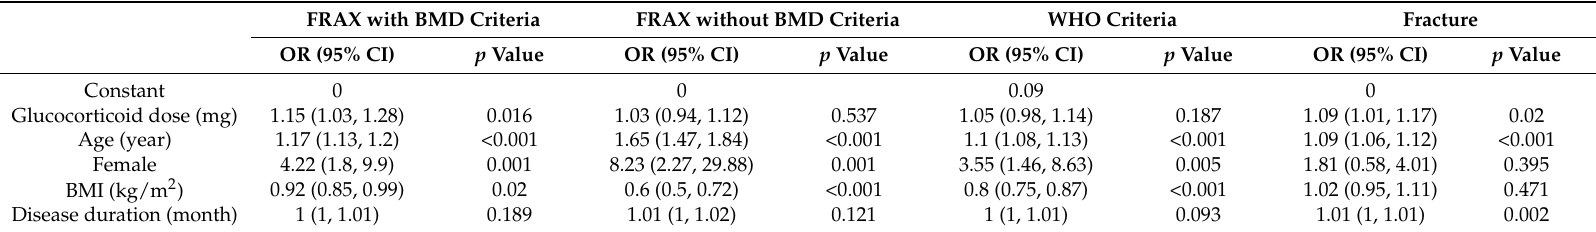
Table 6. Multivariable logistic regression analyses for high-risk of fracture of FRAX criteria and WHO osteoporosis criteria, and fractures in patients with rheumatoid